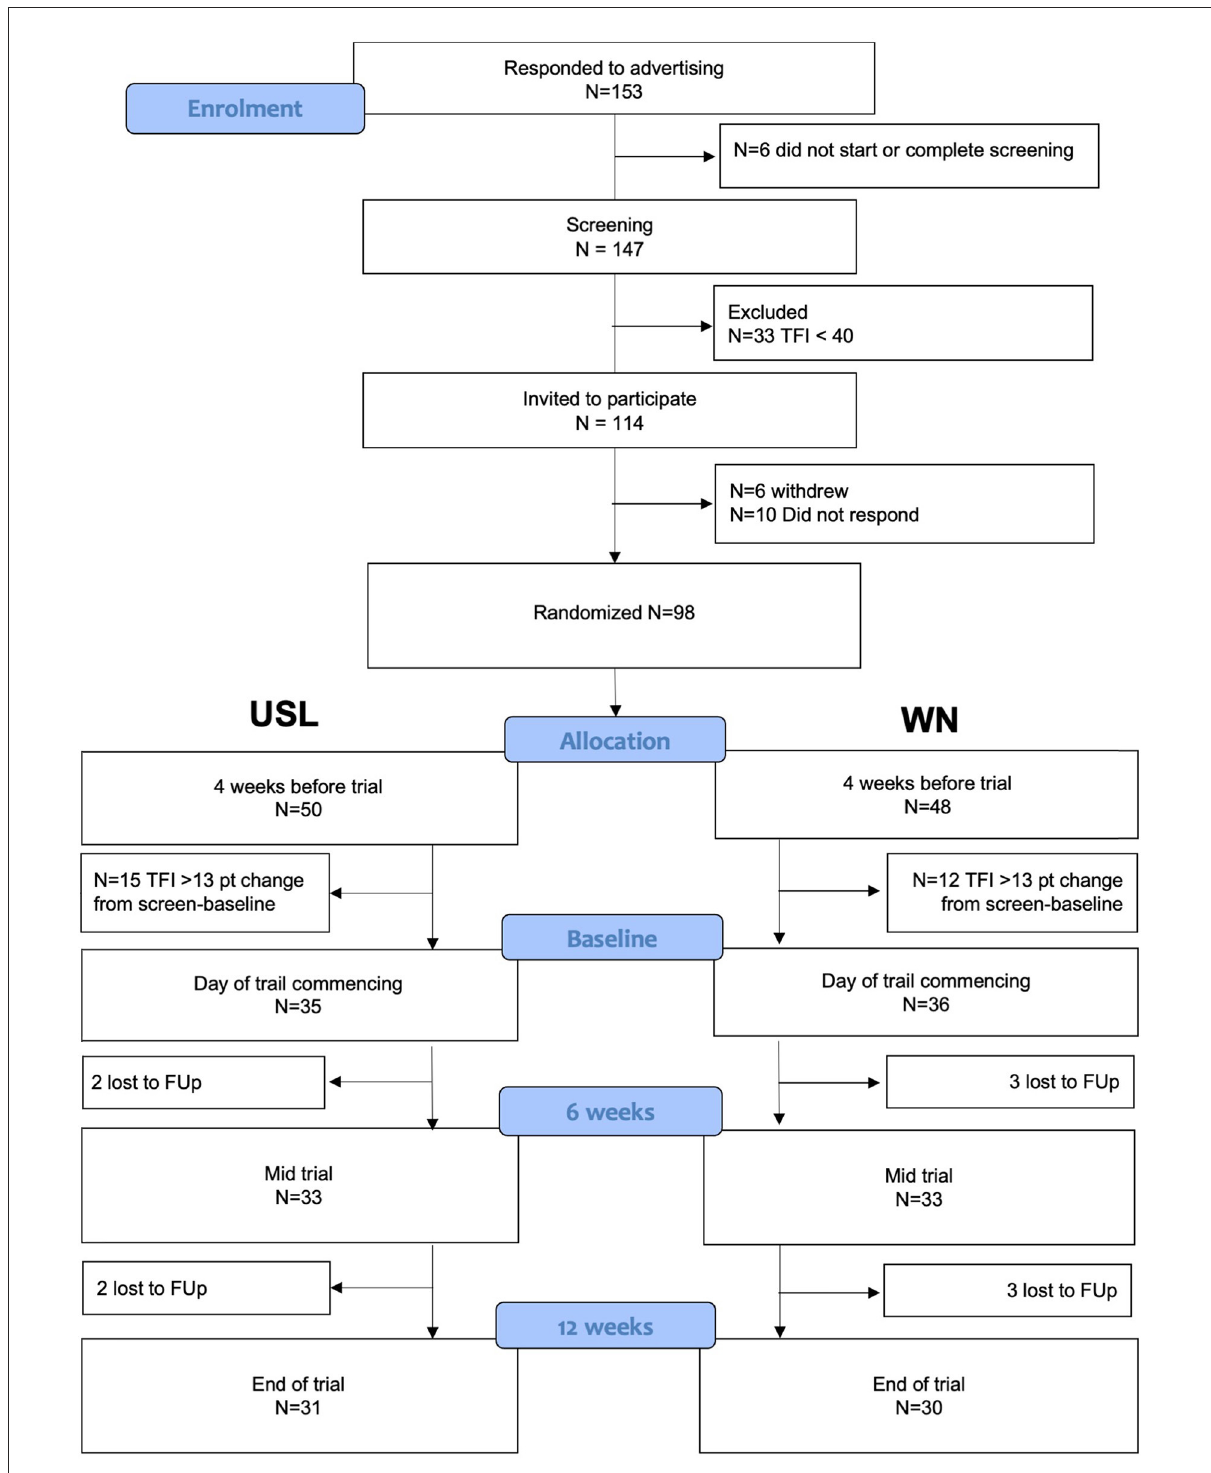
FIGURE1 Consort flow chart for participant recruitment and